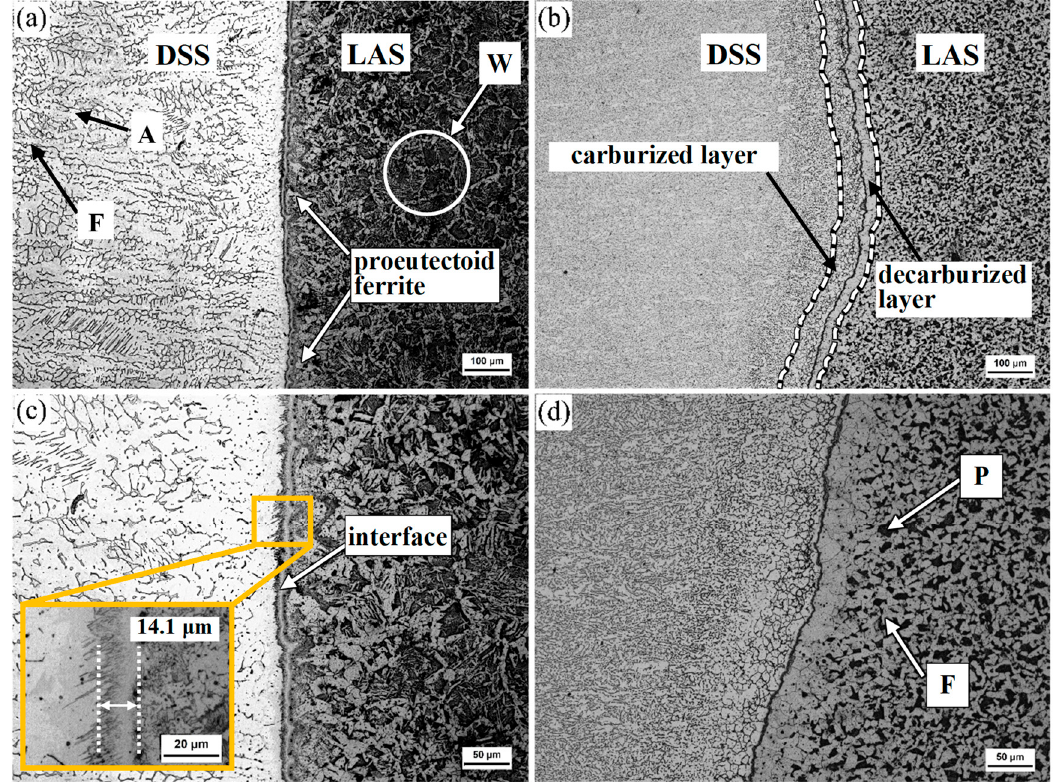
Figure 2. Microstructure of the DSS/LAS-clad rebar before and after rolling: ( a , c ) DSS/LAS billet as deposited, ( b , d ) rolled DSS/LAS clad rebar.